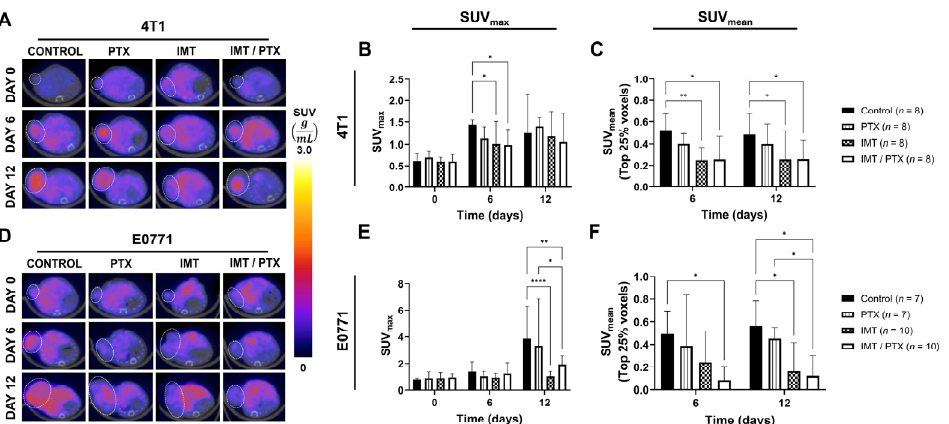
Figure 2. FMISO-PET imaging provides quantitative data on TNBC tumor response. ( A ) Representative FMISO-PET images of 4T1-tumor-bearing mice on days 6 and 12 show differences in intratumoral hypoxia between treatment groups. ( B ) SUV max was significantly lower in IMT ± PTX treated 4T1 tumors on day 6 compared to control, indicating treatment with IMT results in lower hypoxic levels in the tumor ROI. ( C ) SUV mean was significantly lower in IMT ± PTX treated 4T1 tumors on days 6 and 12 compared to control, indicating IMT treatment results in low hypoxic levels in the tumor ROI. ( D ) Representative FMISO-PET images of E0771-tumor-bearing mice on days 6 and 12 show differences in intratumoral hypoxia between treatment groups. ( E ) SUV max was significantly lower in IMT ± PTX treated E0771 tumors on day 12 compared to control, indicating treatment with IMT results in lower hypoxic levels in the tumor ROI. ( F ) SUV mean was significantly lower in IMT ± PTX treated E0771 tumors on days 6 and 12 compared to control, indicating IMT treatment results in low hypoxic levels in the tumor ROI. Mean ± SD (* indicates p < 0.05, ** indicates p < 0.01; **** indicates p < 0.0001; multiple t -tests).